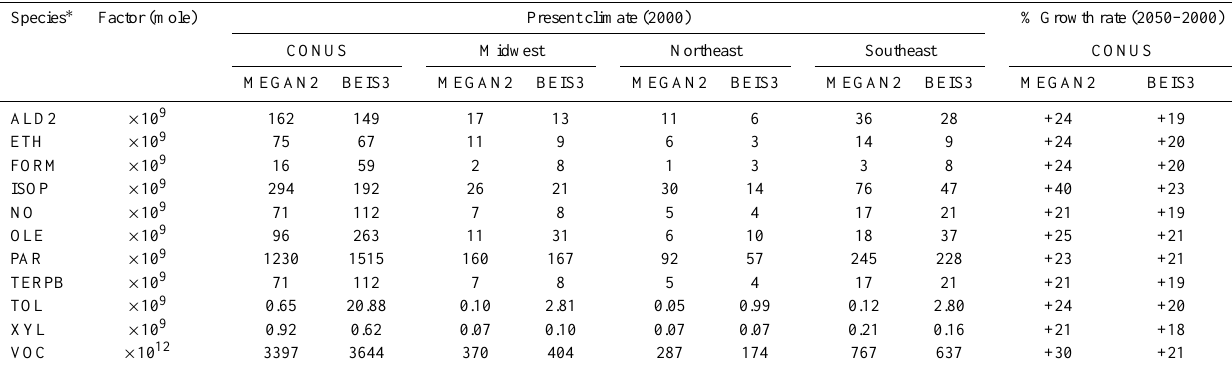
Fig. 1. The CONUS 36 km and VISTAS 12 km domains with selected study areas boxed in red (the dark green color on the map indicates locations of vegetation).